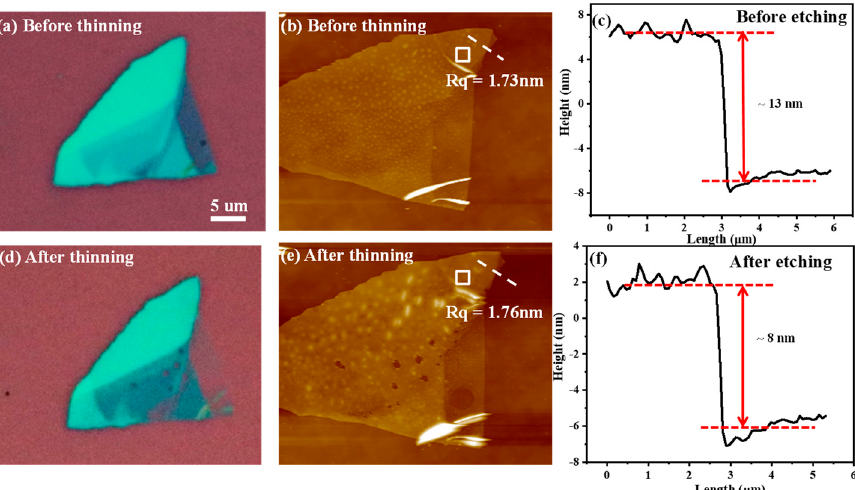
Figure 2. ( a , b ) Optical microscope and AFM image of BP flakes before thinning with a roughness of 1.73 nm at the square. ( c ) The thickness of the flake, which is − 13 nm corresponding to the dotted line in ( b , d , e ), which are optical microscope and AFM images of BP flakes after thinning with a roughness of 1.76 nm at the square. ( f ) The thickness of the flake, which is − 8 nm corresponding to the dotted line in ( e ).